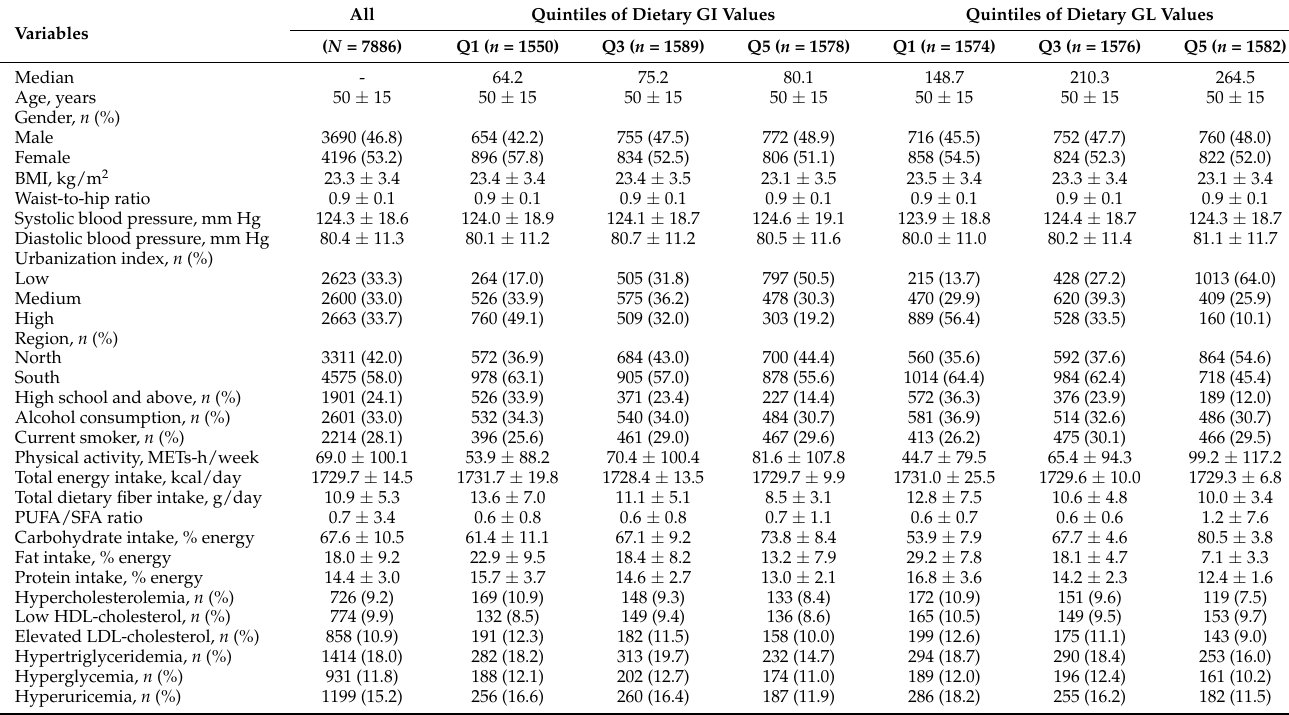
Table 1. Sociodemographic, anthropometric, and lifestyle characteristics of 7886 Chinese adults who participated in the China Health and Nutrition Survey 2009 according to quintiles of dietary glycemic index (GI) and dietary glycemic load (GL) values ( N = 7886) 1